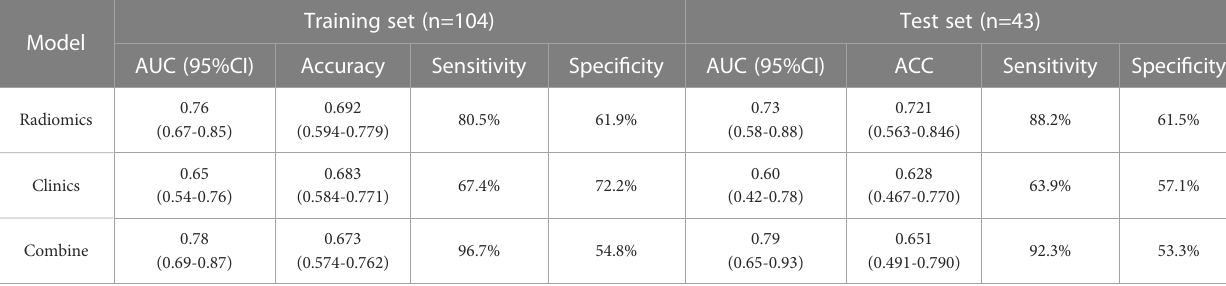
TABLE 3 Predictive performance of radiomics, clinics, and combined models.